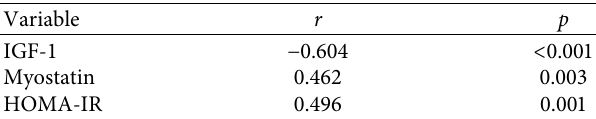
Figure 3: Comparisons of HOMA-IR levels in sarcopenia status group. Table 3: Correlation of IGF-1, myostatin, and HOMA-IR with sarcopenia